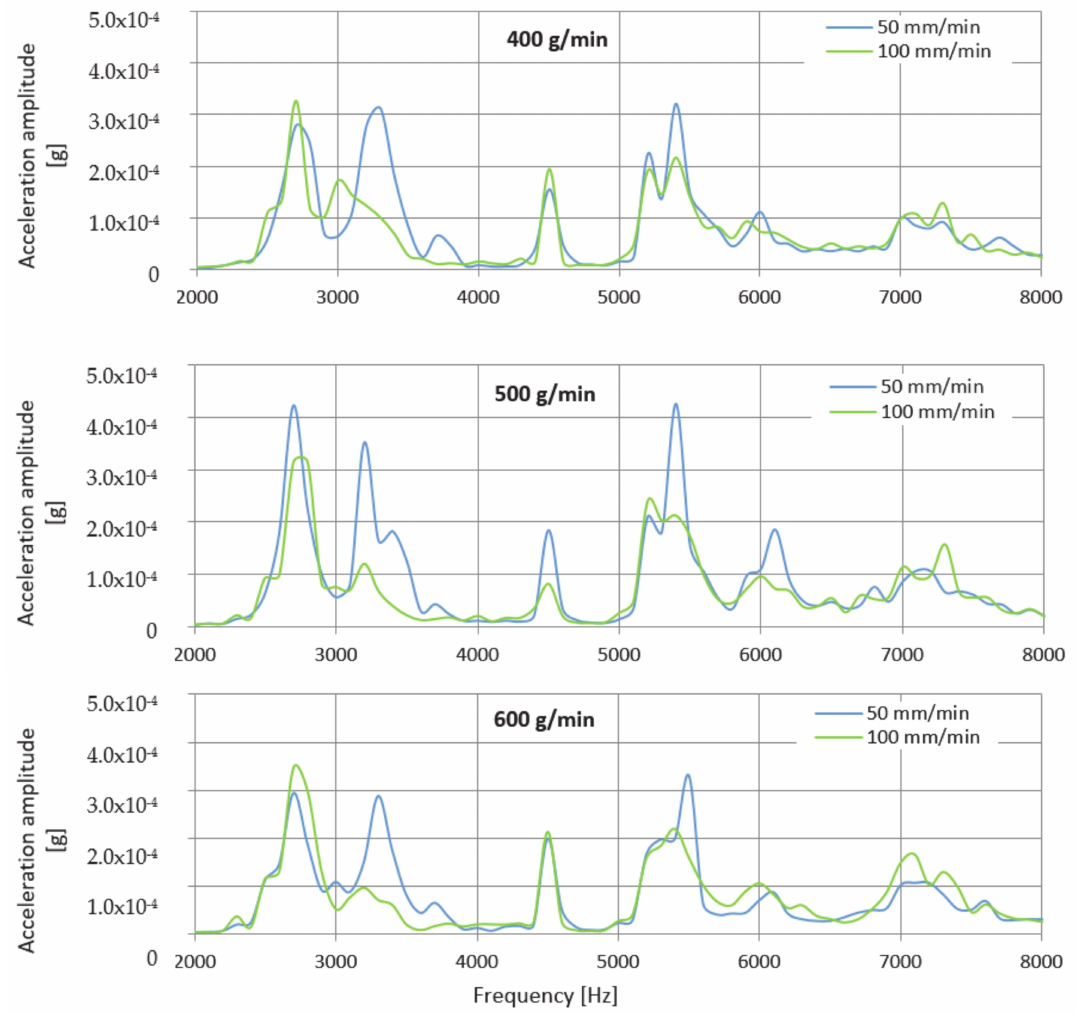
Figure 6. Graphs comparing envelopes of frequency spectra when cutting with an